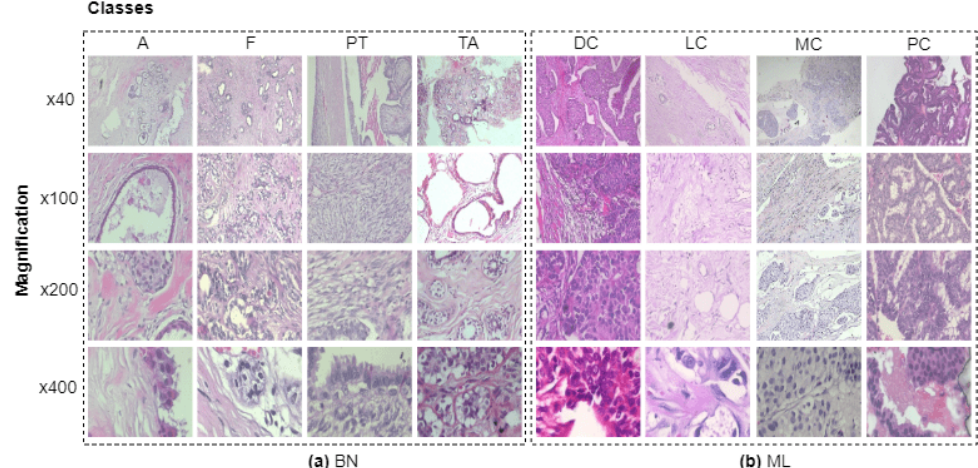
Figure 1. Illustration of H & E -stained breast tumour patch examples extracted from the different magnifications of whole slide image (WSI). Note that ( a ) benign and ( b ) malignant correspond to the BN and ML, respectively. It contains four histological subtypes of benign breast tumours: adenosis (A), fibroadenoma (F), phyllodes tumour (PT), and tubular adenona (TA); and four malignant tumours (breast cancer): carcinoma (DC), lobular carcinoma (LC), mucinous carcinoma (MC), and papillary carcinoma (PC). These sub-categorized breast tumours are distinct in their visual, textural patterns and color